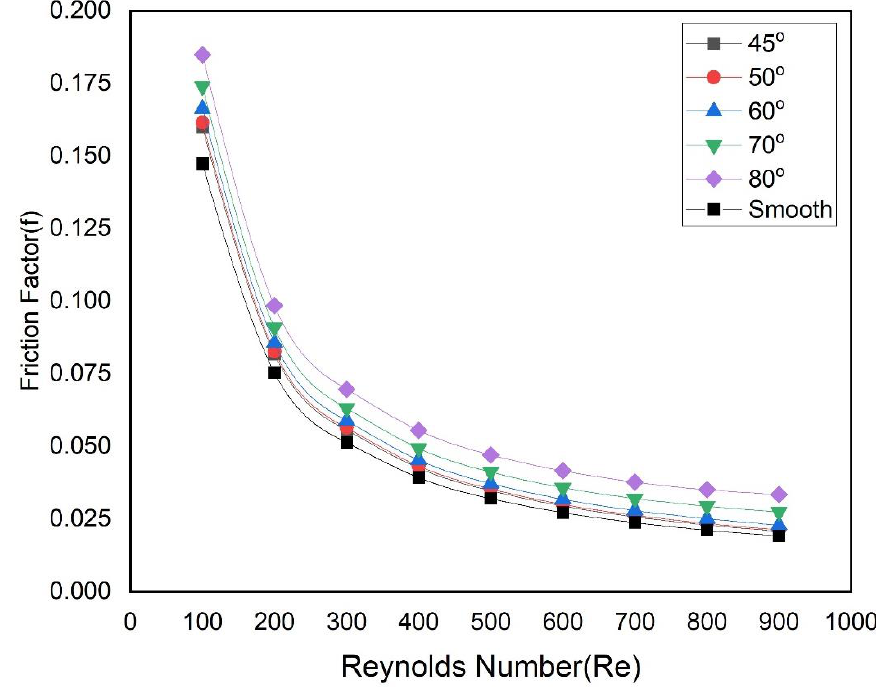
Figure 12. Friction factor varies with Reynolds number at various